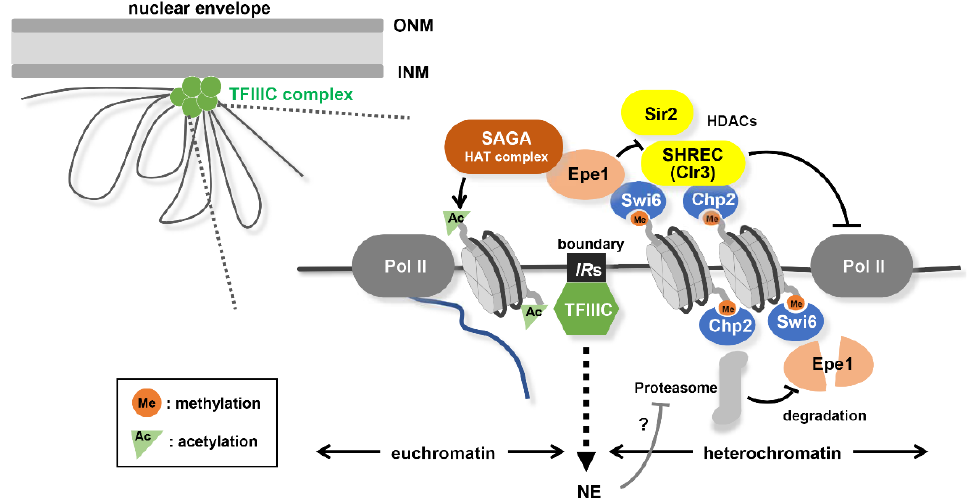
Figure 3. Formation of heterochromatin / euchromatin boundary. Boundary elements ( IR s) clustered at the nuclear periphery through TFIIIC binding. Epe1 (anti-silencing factor) is specifically accumulated at the boundary ( IR s) owing to the proteasome-mediated selective elimination of Epe1 from heterochromatin. A heterochromatin / euchromatin boundary is formed owing to a balance between the opposing activity of histone acetyltransferase (SAGA recruited by Epe1) and histone deacetylase (SHREC or Sir2 recruited by Swi6 and Chp2).